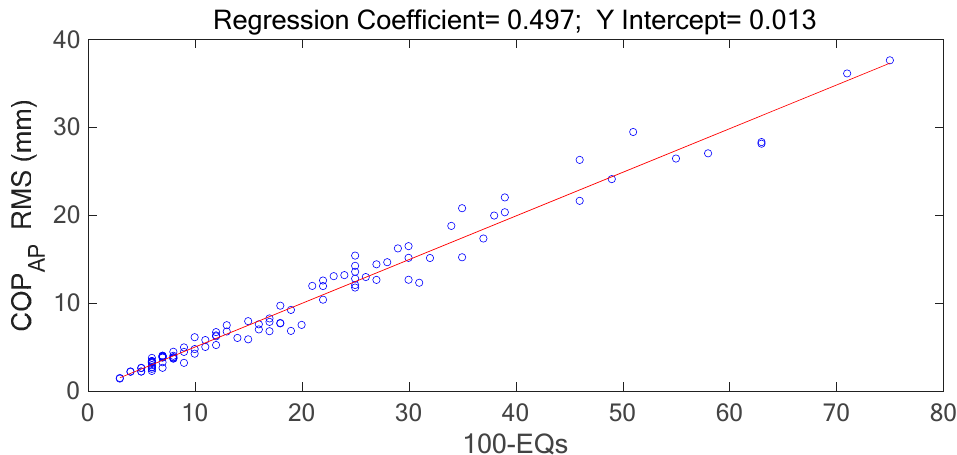
Figure 12. Regression analysis for RMS values of COP measurement in the AP direction and the swaying level (100 EQs).